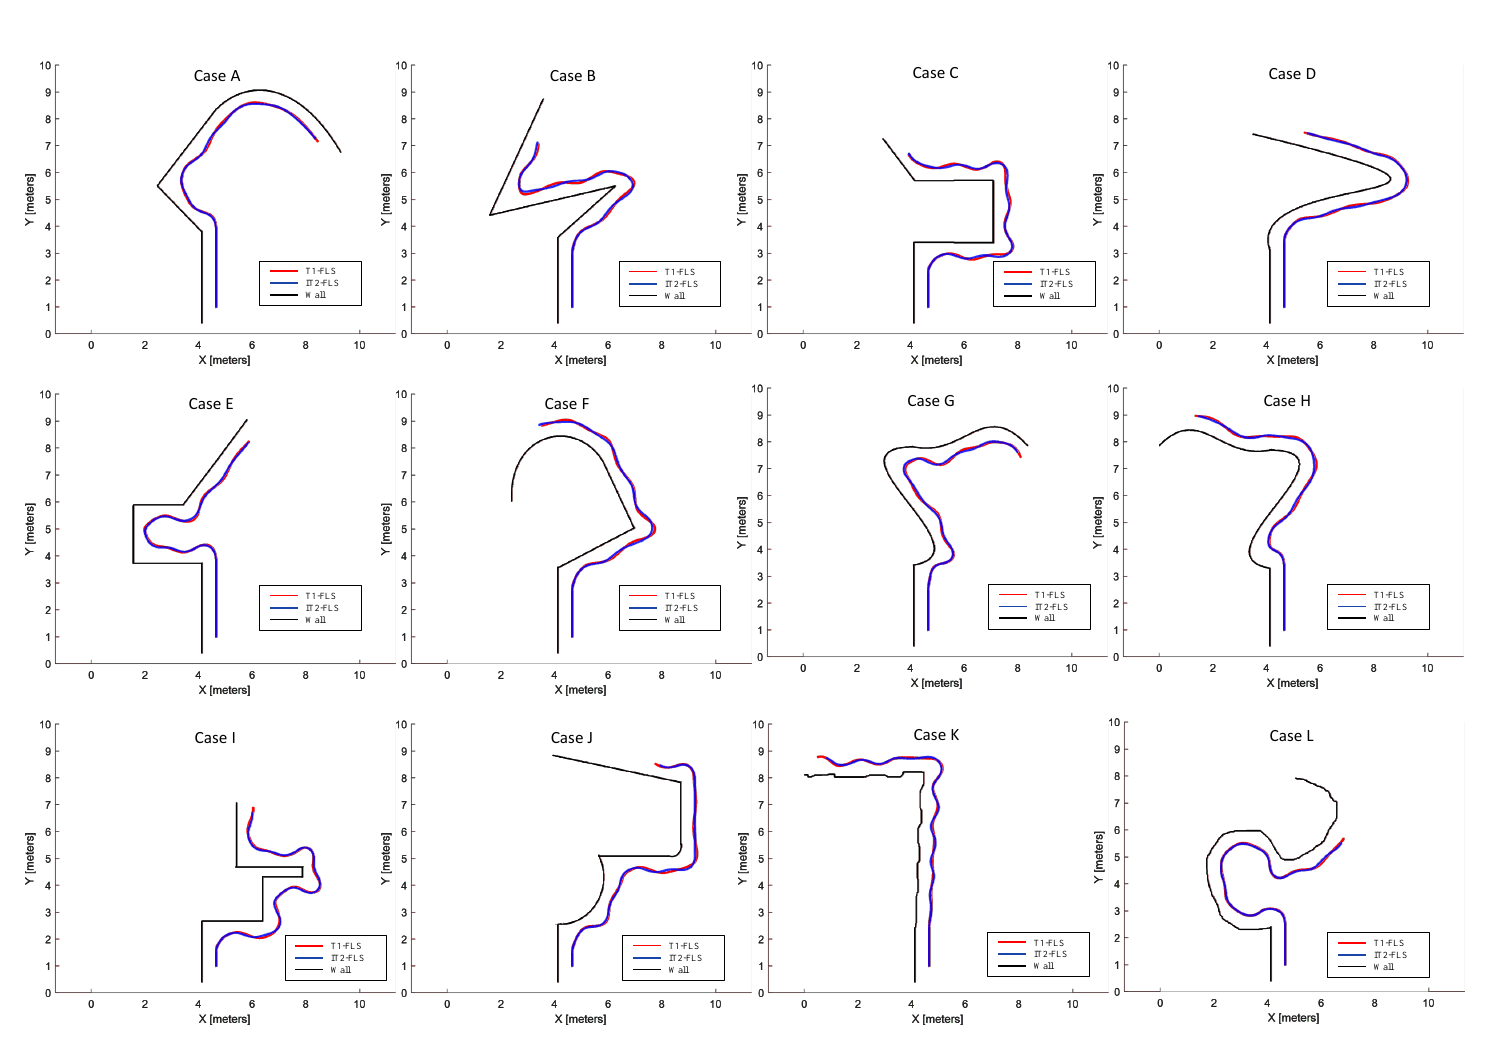
Figure 10. The traced path of the robot during the second phase of the validation. Cases A to L represent the test